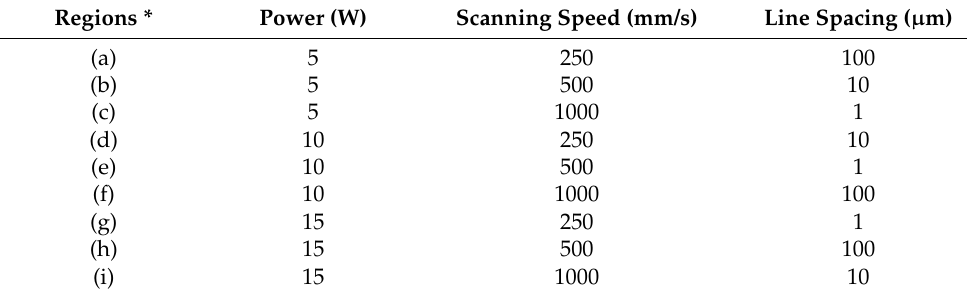
Table 2. The orthogonal experimental design.